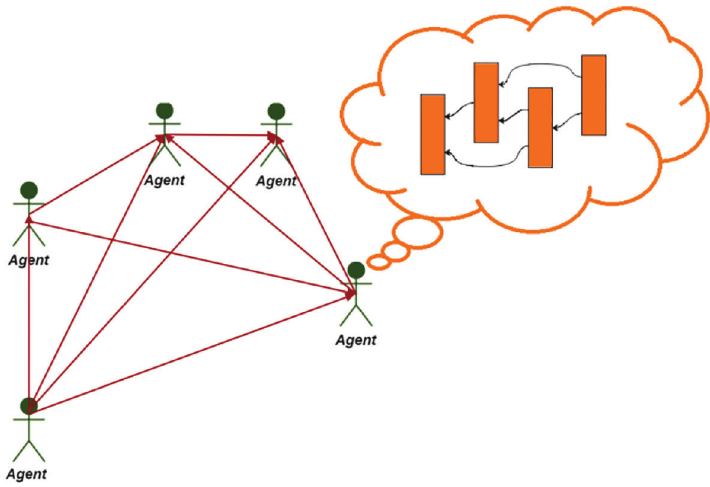
Figure 2. Agent based simulation system. Lines represent the interactions between agents and orange rectangles represent the decision-making process of each